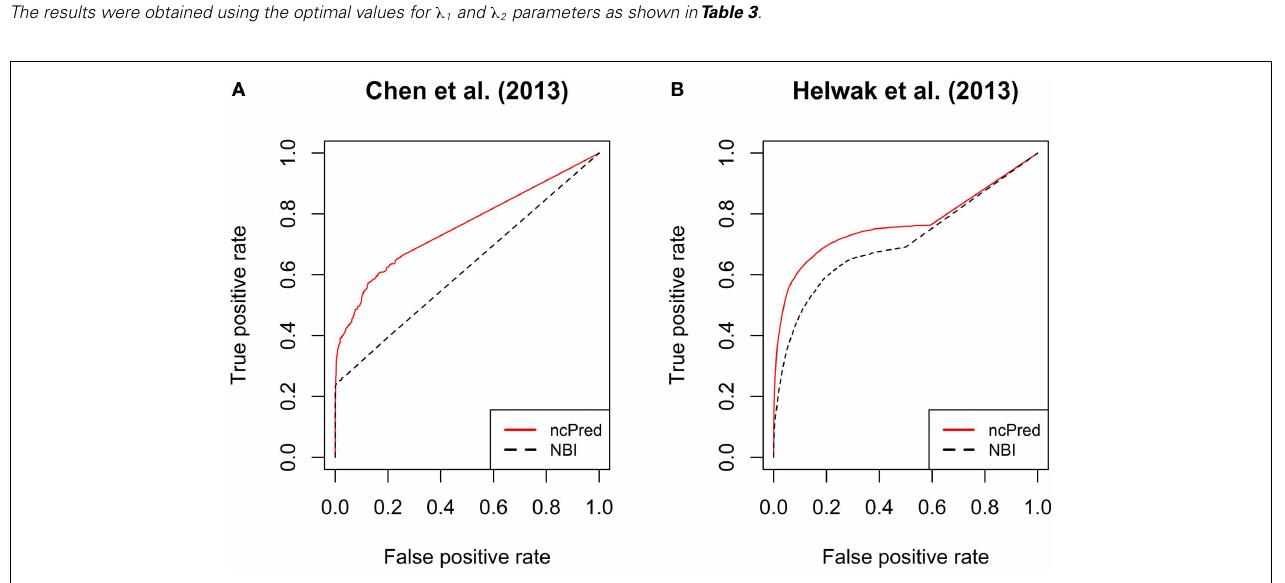
FIGURE 3 | Comparison between ncPred andYang et al. (2014) by means of receiver operating characteristic (ROC) curves, computed for the recommendation lists built on our two datasets . Such curves measure the quality of the algorithms in terms of false positives rate against true positives